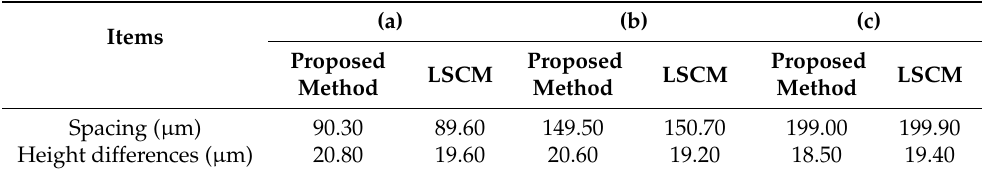
Table 2. The reconstruction values compared with the measurement results of LSCM. Here ‘Spacing’ denoted the spacings between the cylinders, ‘Height differences’ denoted the average height differences, and (a), (b) and (c) corresponded to the cylinder arrays C1, C2 and C3.